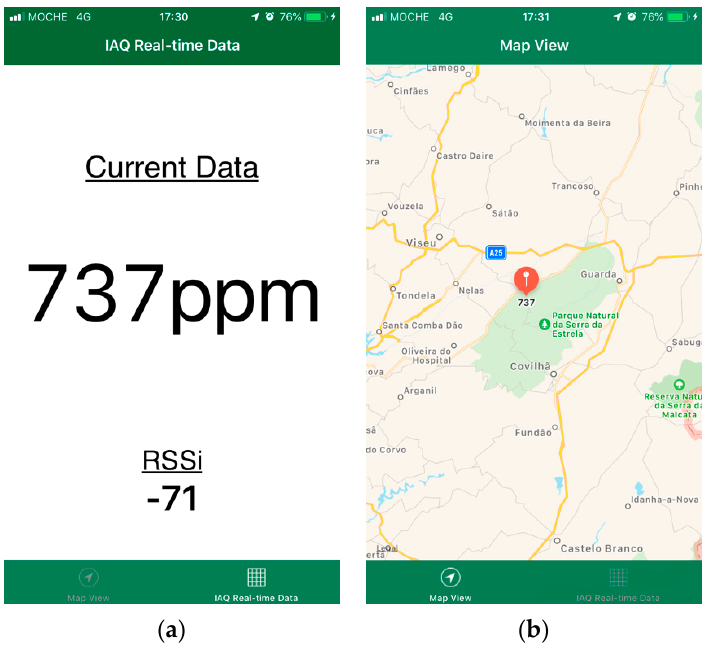
Figure 4. (a) CO 2 collected data; (b) corresponding map view . Figure 4. ( a ) CO 2 collected data; ( b ) corresponding map